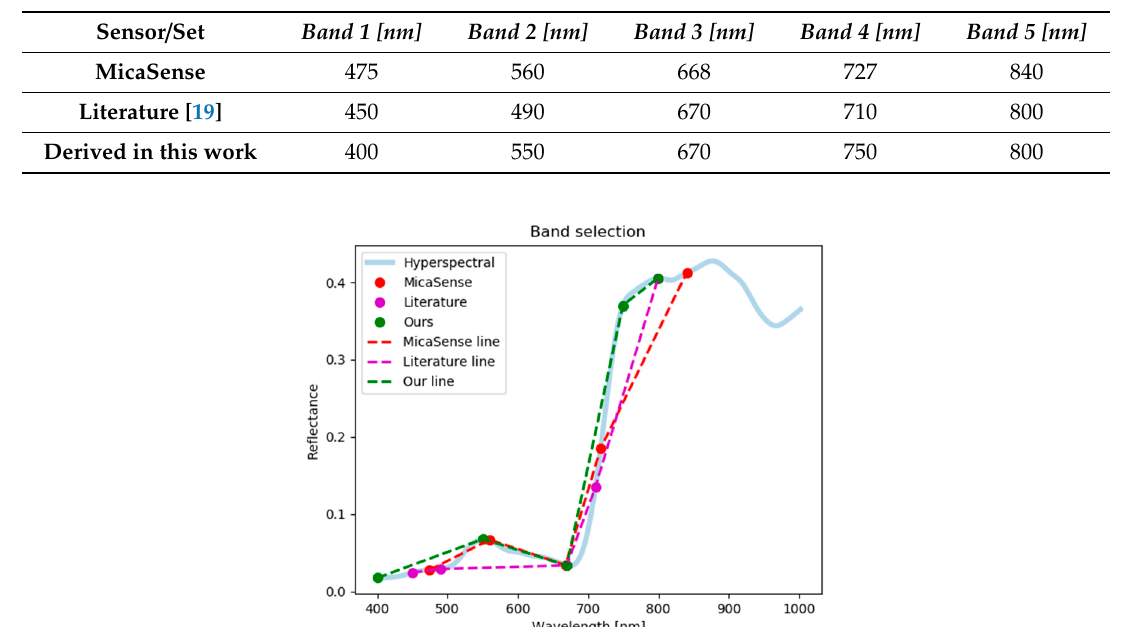
Table 5. Comparison between MicaSense wavelengths, informative wavelengths previously published and a newly derived set of informative wavelengths.